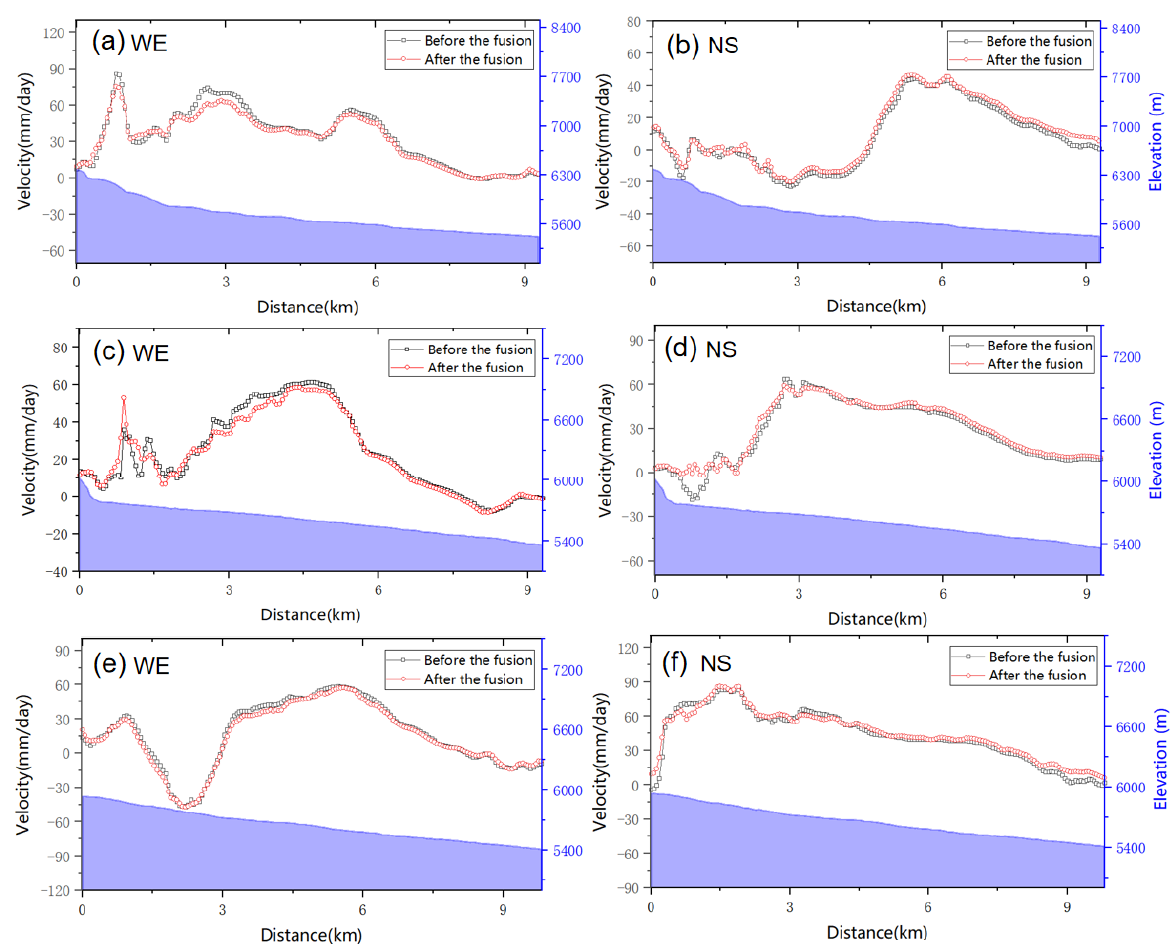
Figure 9. Profiles of glacial flow rate before and after fusion: ( a , c , e ) west–east flow velocity profiles along A, B, and C (Figure 7); ( b , d , f ) south–north flow velocity profiles along A, B, and C.